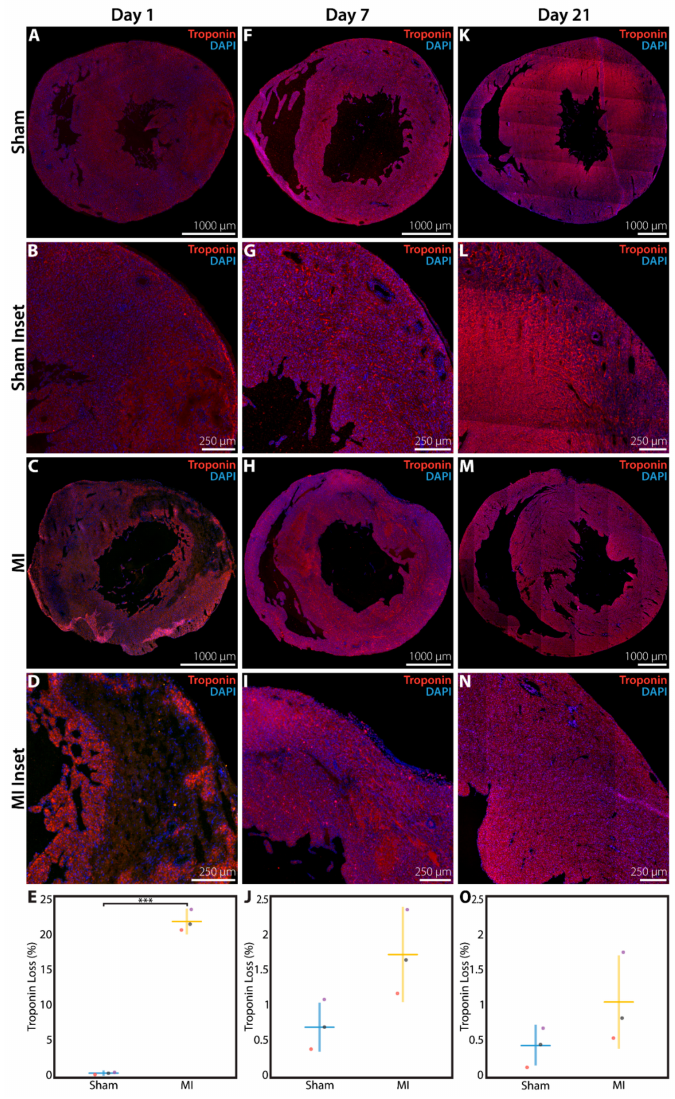
Figure 3. Troponin immunohistochemistry assessment of the neonatal rat heart at 1 day, 1 week, or 3 weeks after sham surgery or induction of myocardial infarction (MI) on postnatal day 1 (P1). ( A ) Sham heart at 1 day after P1 surgery ( n = 3), with ( B ) inset. ( C ) MI heart at 1 day after P1 surgery ( n = 3), with ( D ) inset showing significant loss of troponin + cardiomyocytes. ( E ) Quantified percentage of left ventricular area devoid of troponin signal at 1 day after P1 surgery. ( F ) Sham heart at 1 week after P1 surgery ( n = 3), with ( G ) inset. ( H ) MI heart at 1 week after P1 surgery ( n = 3), with ( I ) inset showing minimal loss of troponin + cardiomyocytes. ( J ) Quantified percentage of left ventricular area devoid of troponin signal at 1 week after P1 surgery. ( K ) Sham heart at 3 weeks after P1 surgery ( n = 3), with ( L ) inset. ( M ) MI heart at 3 weeks after P1 surgery ( n = 3), with ( N ) inset showing minimal loss of troponin + cardiomyocytes. ( O ) Quantified percentage of left ventricular area devoid of troponin signal at 3 weeks after P1 surgery. *** indicates p < 0.001. Horizontal lines indicate mean. Vertical lines indicate standard